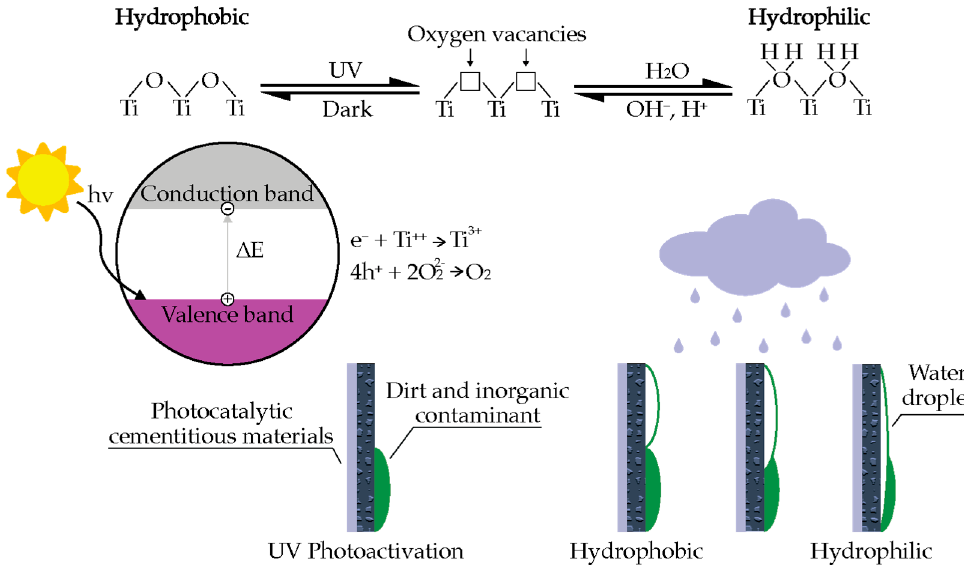
Figure 8. Mechanism of photoinduced hydrophilicity.